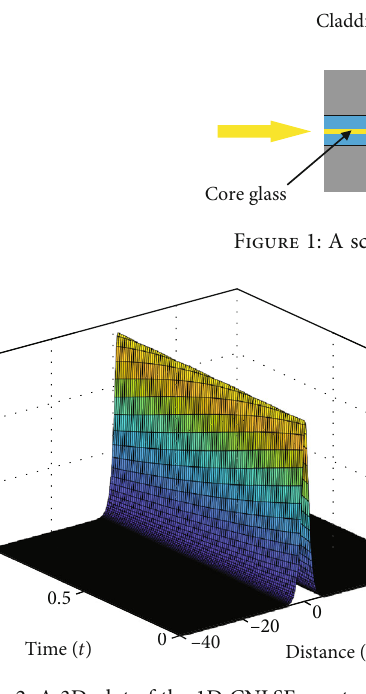
Figure 2: A 3D plot of the 1D CNLSE exact